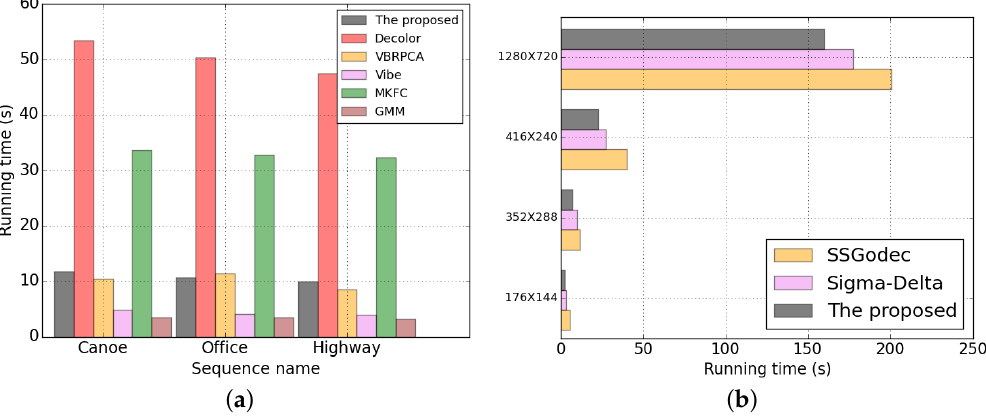
Figure 13. Running time evaluation for several ROI detection approaches. ( a ) Time consumption varies from different sequences. ( b ) Time consumption varies from different